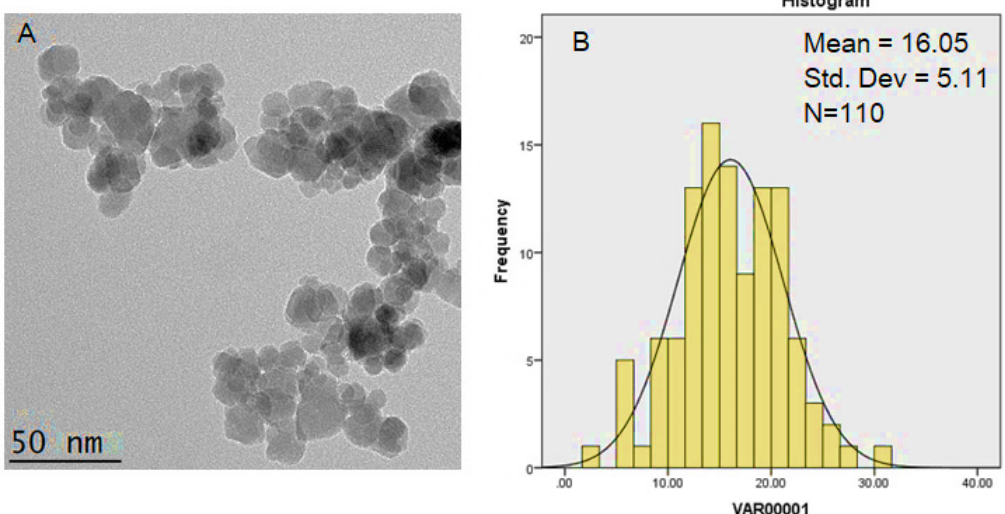
Figure 8. Transmission electron micrographs for ( A ) drug-loaded magnetic nanoparticles (50 nm bar); ( B ) their particle size distribution .